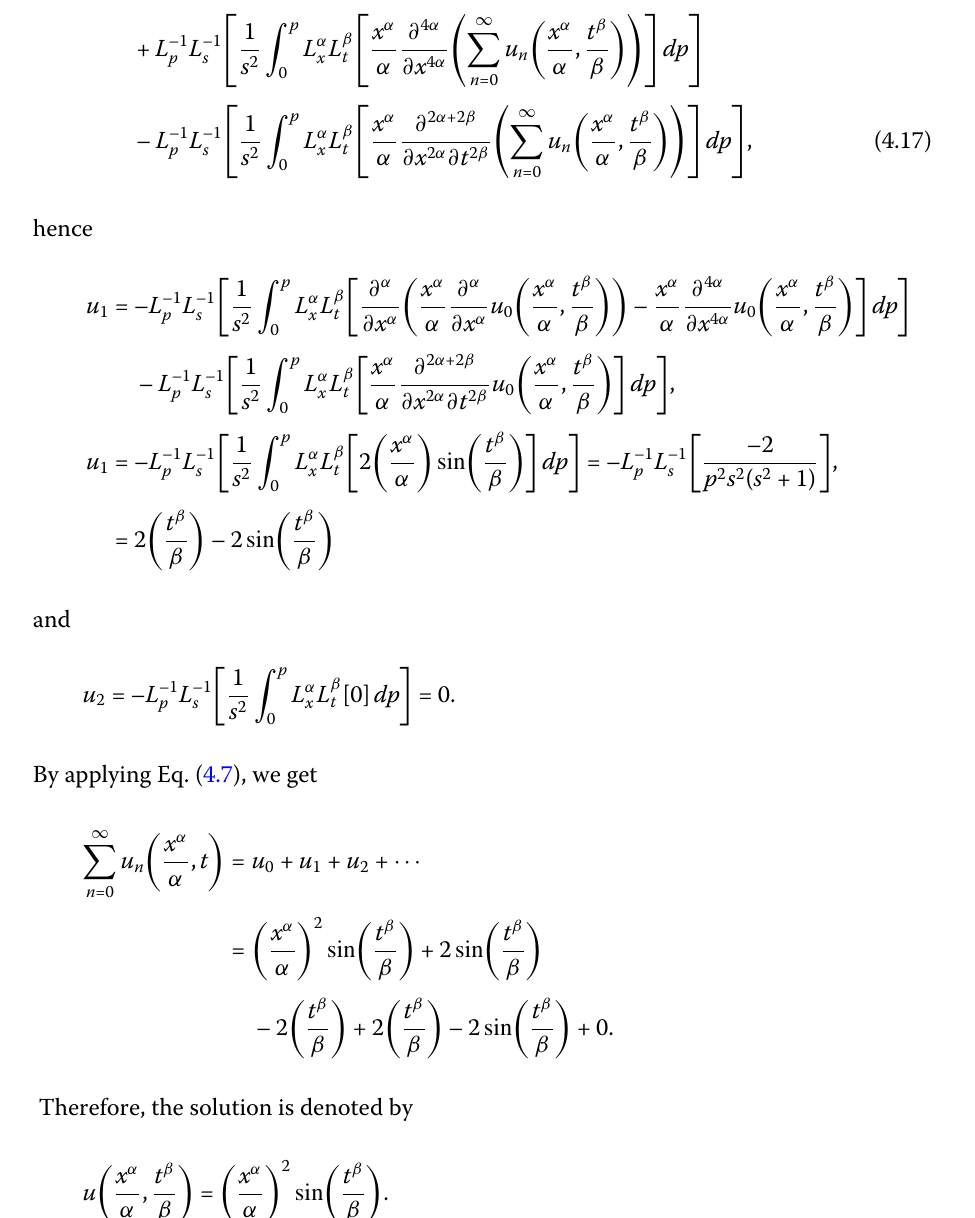
Figure 1 The exact and approximate solutions of u(x,t), for Example 4, we take different values of fractional orders of α and β : α = 0.99, β = 0.55, α = 0.98, β = 0.66, α = 0.97, β = 0.77, and α = 0.96, β =